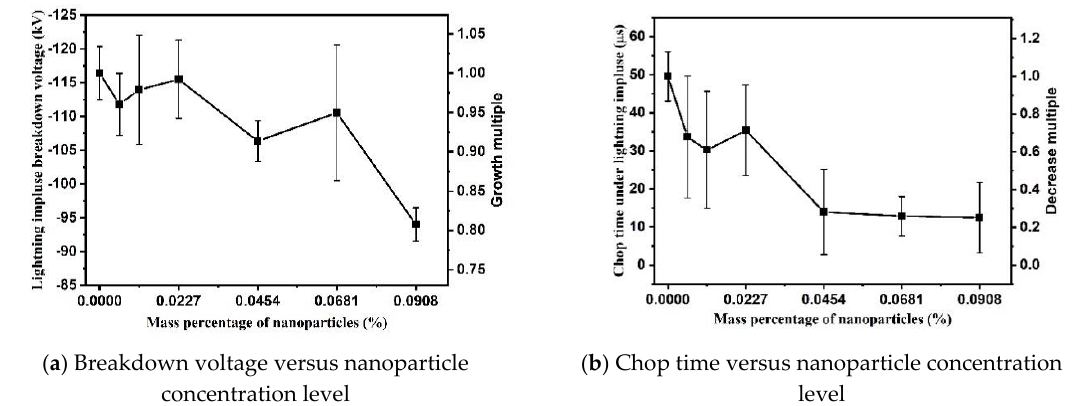
Figure 5. Negative impulse breakdown performance of TiO 2 nanofluids.